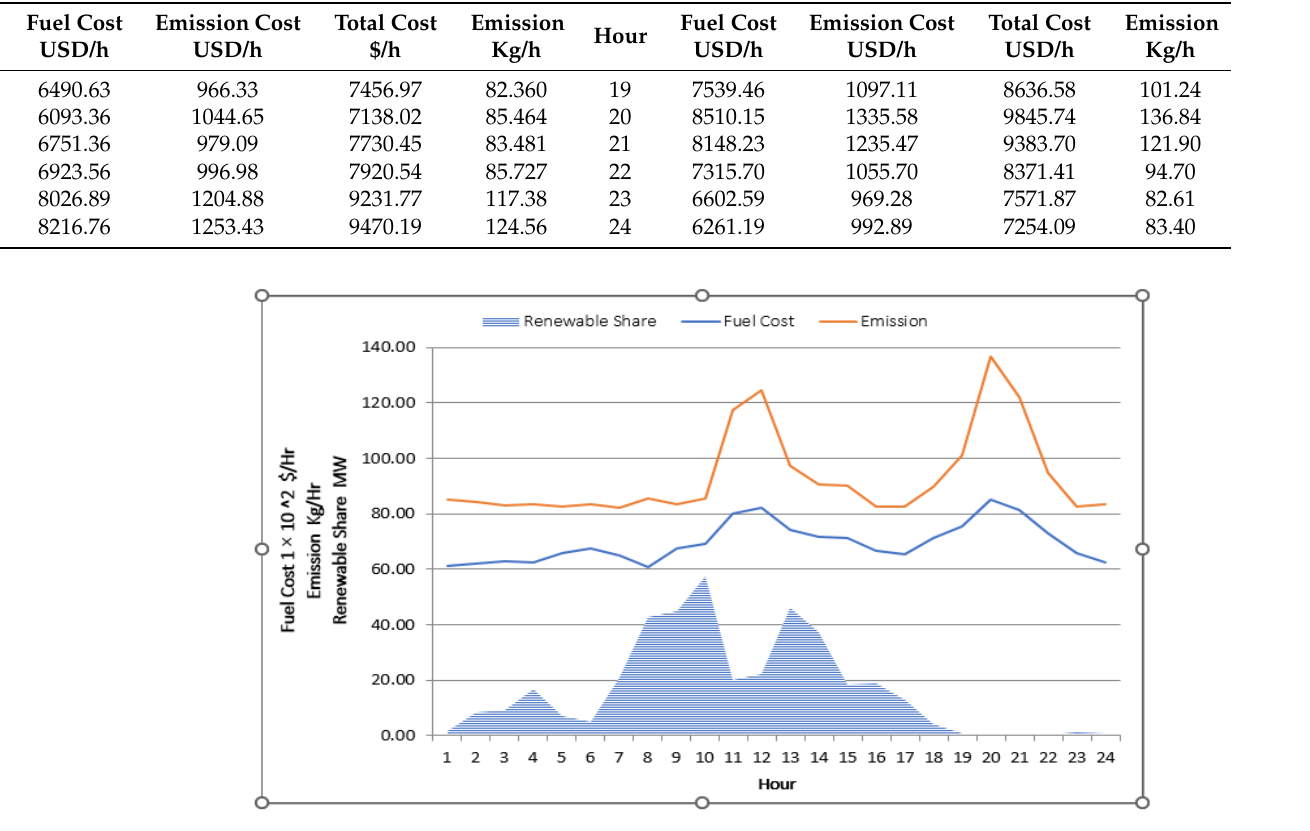
Figure 5. Effect of integrating RES on fuel cost and emissions — case study 1. Table 5. Fuel-cost comparison between CISSA and ACO.